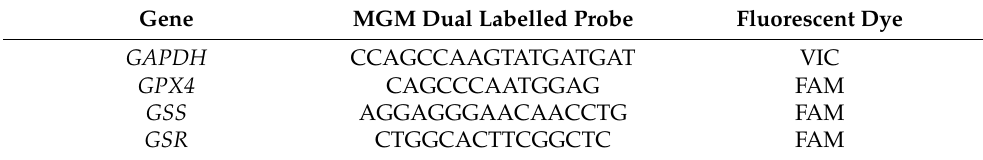
Table 4. MGB-NFQ dual-labeled probes of target and endogenous genes. Gene MGM Dual Labelled Probe Fluorescent Dye GAPDH CCAGCCAAGTATGATGAT VIC GPX4 CAGCCCAATGGAG FAM GSS AGGAGGGAACAACCTG FAM GSR CTGGCACTTCGGCTC